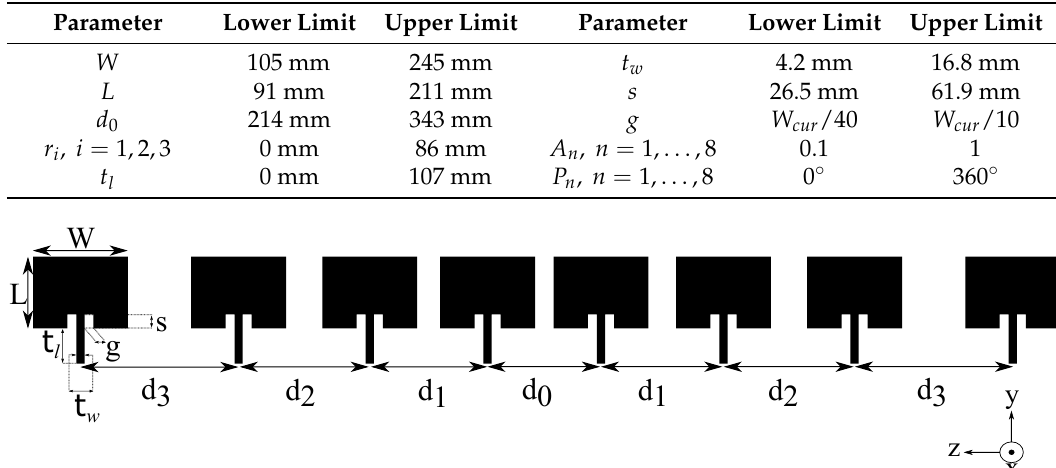
Figure 2. Geometry of the proposed aperiodic microstrip antenna array